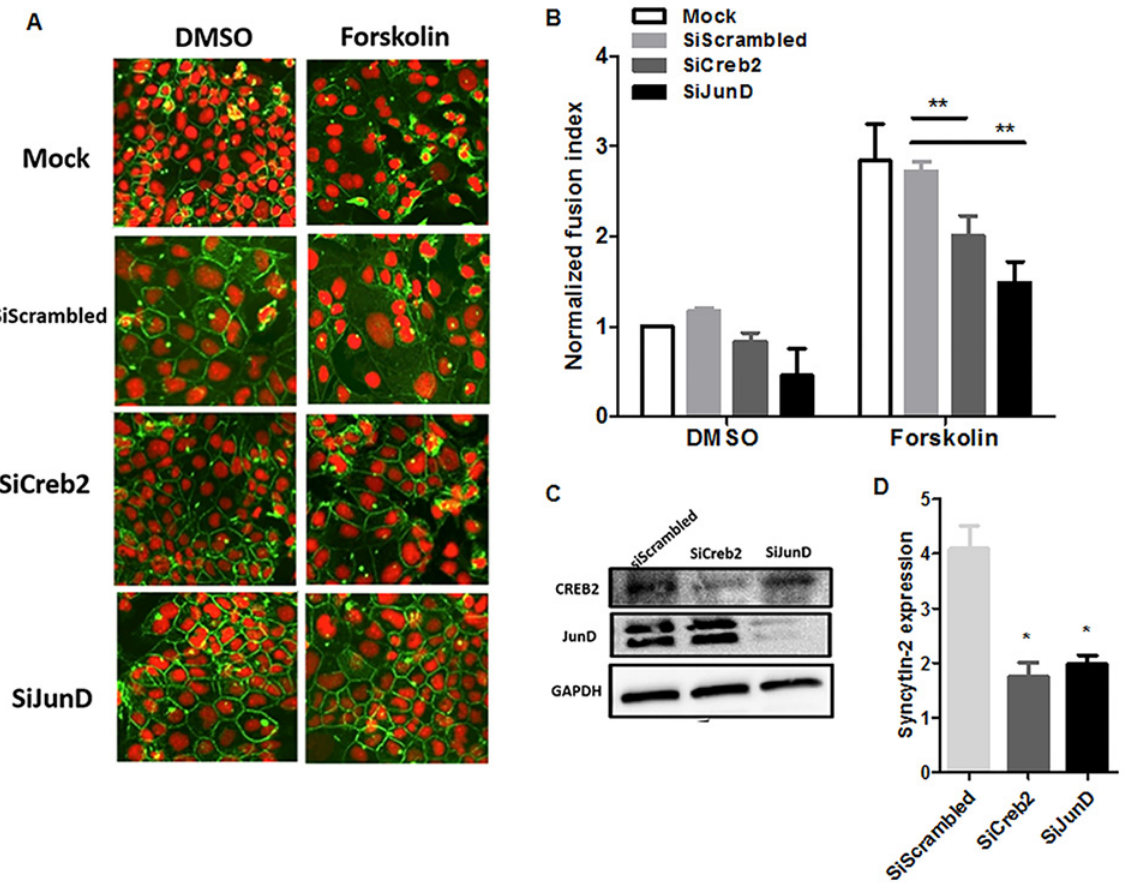
Fig 8. Silencing of either JunD or CREB2 reduces Syncytin-2 expression and fusion of stimulated BeWo cells. BeWo cells were stimulated with forskolin or left untreated (DMSO) and transfected with 37,5 ng CREB-2- or JunD-specific siRNA vs. scrambled control siRNA. ( A, B ) Cell fusion index was calculated for each transfected cell samples by confocal microscopy analyzed with anti-desmoplakin antibodies and propidium iodide staining. ( C-D ) Western blot analyses were performed on cellular extracts from each transfected cell samples using anti-JunD, anti-CREB2 and anti-GAPDH antibodies (left panel). Analyses for Syncytin-2 proteins levels were normalized against GAPDH signals and band intensities are depicted in ( D ) ( * p < 0.05; ** p <